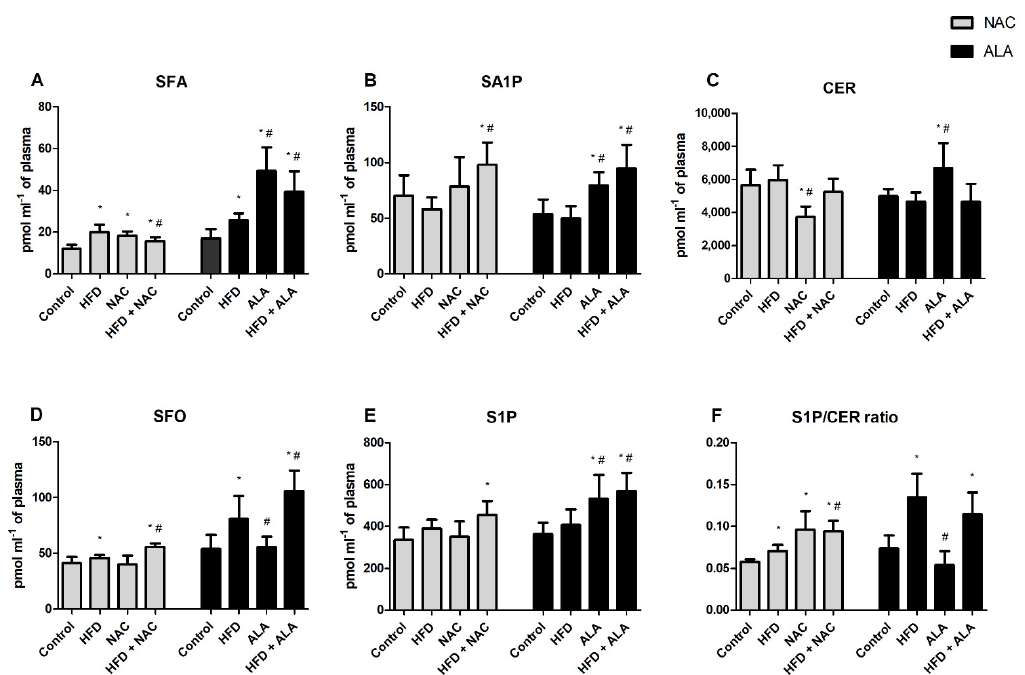
Plasma content of sphingolipid pathway components, i.e., ( A ) sphinganine (SFA), ( B ) sphinganine-1-phosphate (SA1P), ( C ) ceramide (CER), ( D ) sphingosine (SFO), ( E ) sphingosine-1-phosphate (S1P), ( F ) sphingosine-1-phosphate/ceramide ratio (S1P/CER ratio) after eight-week treatment of n-acetylcysteine (NAC) or α -lipoic acid (ALA) in rats fed a standard diet (Control group) or high-Fat Diet (HFD group). The data are expressed as the mean values ± SD and are based on ten independent determinations ( n = 10). * p < 0.05 significant difference vs. corresponding Control group; # p < 0.05 significant difference vs. corresponding high-fat diet group.